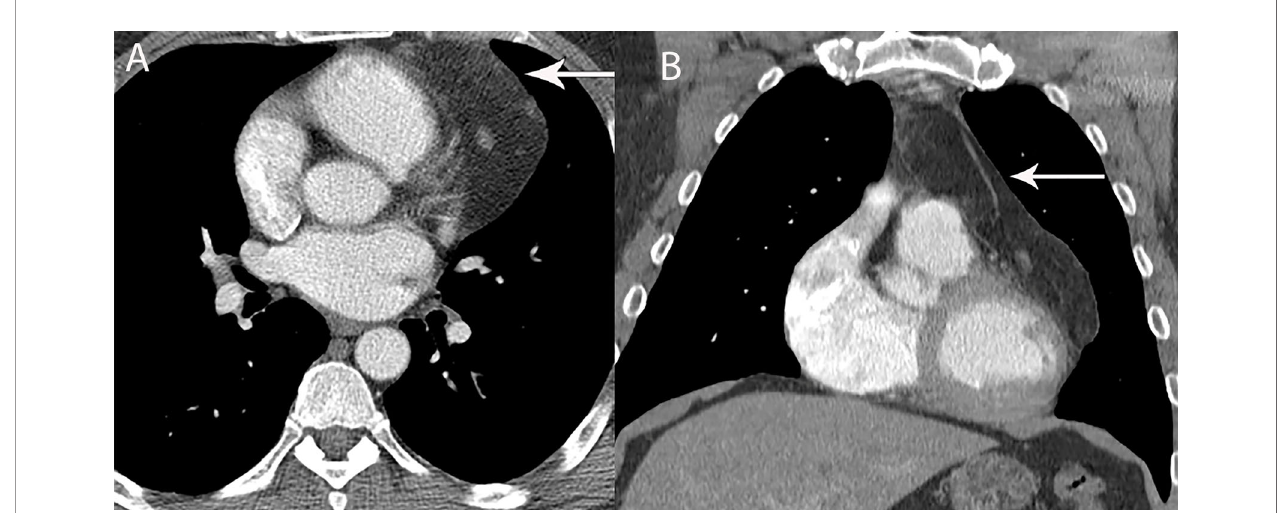
FIGURE 8 | 49 year old man with thymolipoma. (A, B) Axial and coronal contrast-enhanced CT shows large left prevascular mediastinal lesion with fat attenuation